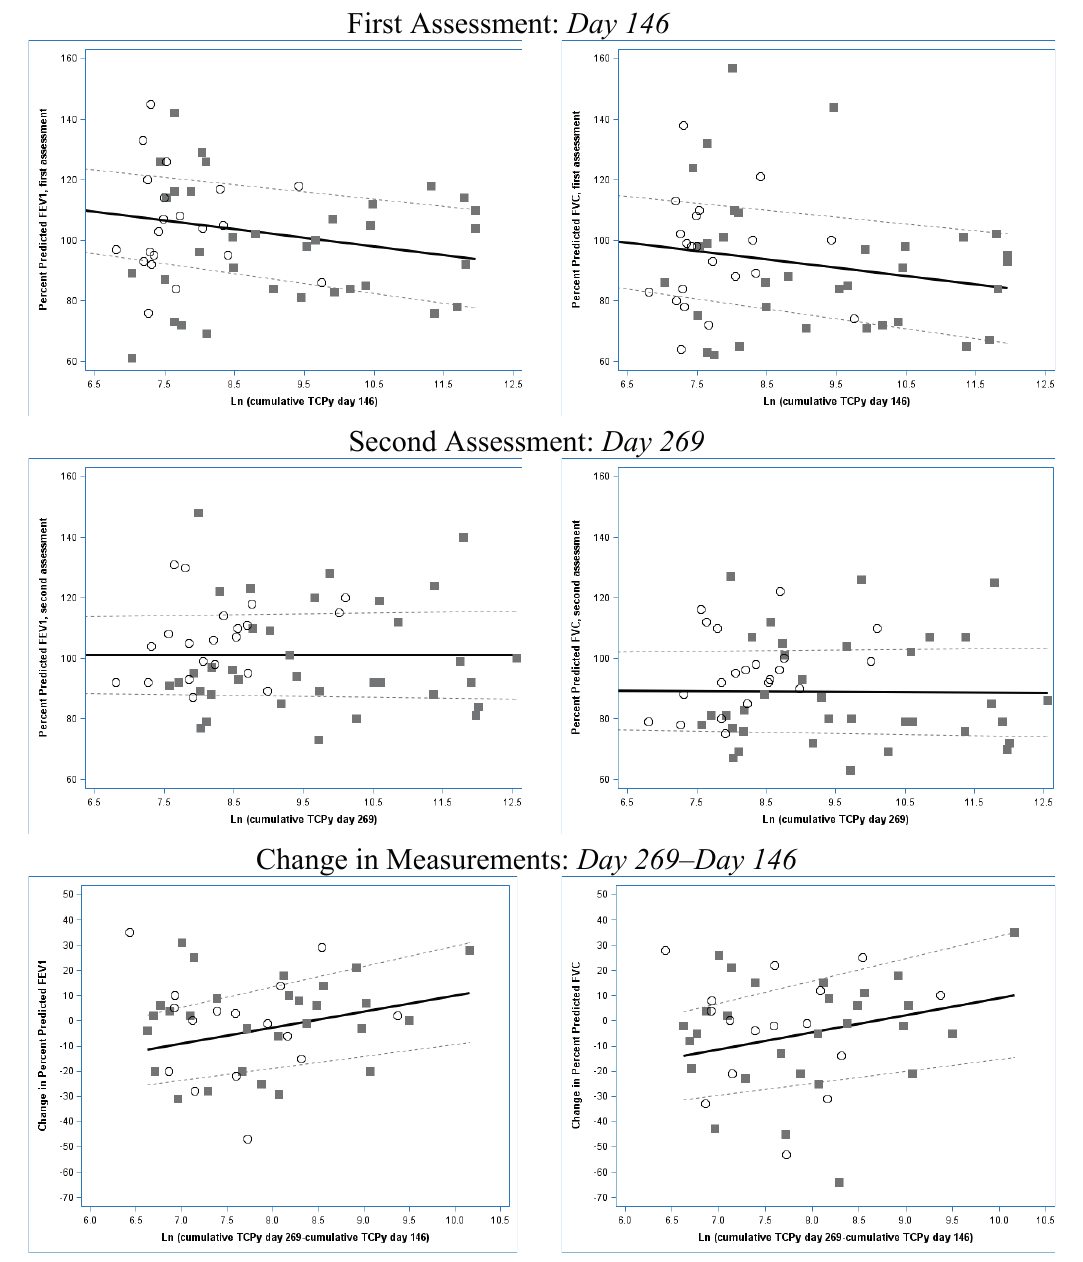
Figure 1. Scatterplots of cumulative urinary 3,5,6-trichloro-2-pyridinol (TCPy) and ) in one second and percent predicted percent predicted forced expiratory volume (FEV 1 forced vital capacity (FVC). Models are adjusted for age weight, height, mixing pesticides at home, and diesel exhaust. Applicators are represented by grey squares; non-applicators are represented by white circles; upper and lower confidence intervals are represented by grey dashed